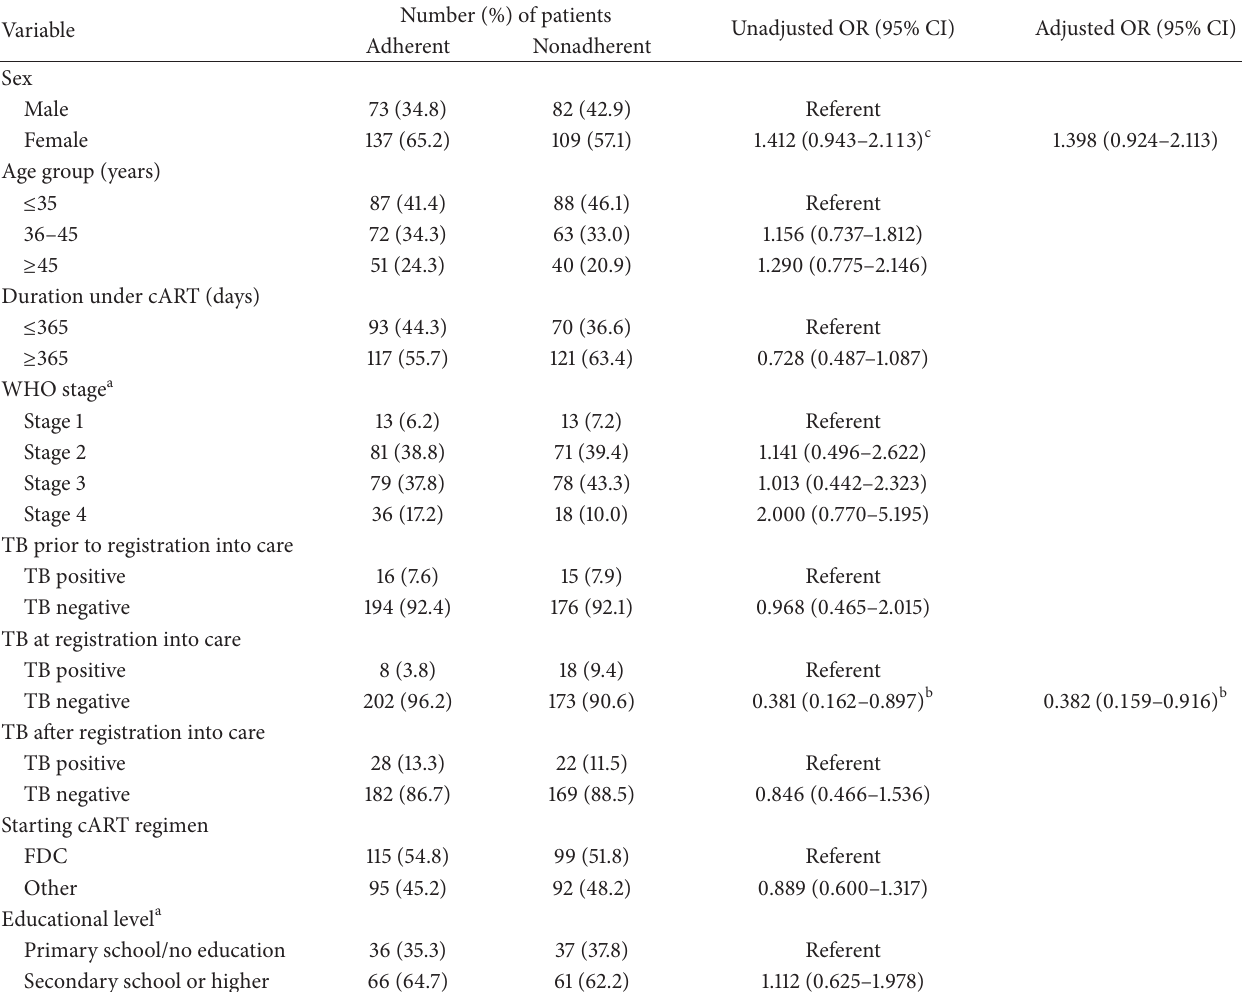
Table 3: Association between cART adherence and selected sociodemographic and clinical risk